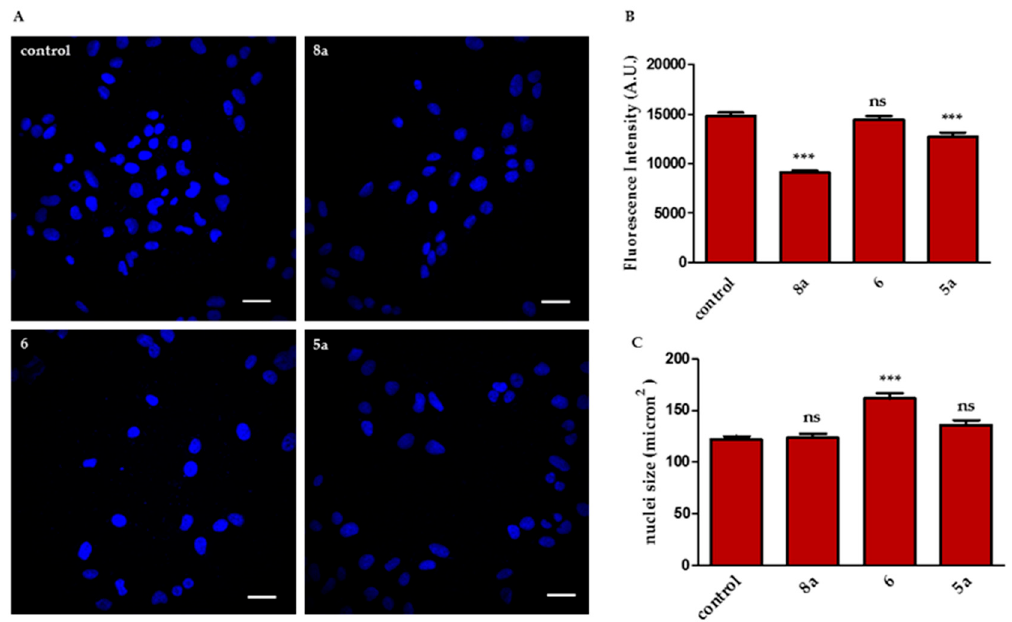
Figure 5. Confocal microscopy of Hoechst 33,342 nuclear staining in control and treated U2OS cells. ( A ) U2OS cells were treated with compounds 5a , 6 , or 8a for 24 h, and then stained with Hoechst 33,342. Representative images are shown (scale bar = 20 µ m). ( B ) Image densitometry measured using ImageJ (*** p < 0.01 with respect to control). ( C ) Cell size was estimated by Hoechst 33,342 staining by image densitometry using ImageJ (*** p < 0.01 with respect to control).